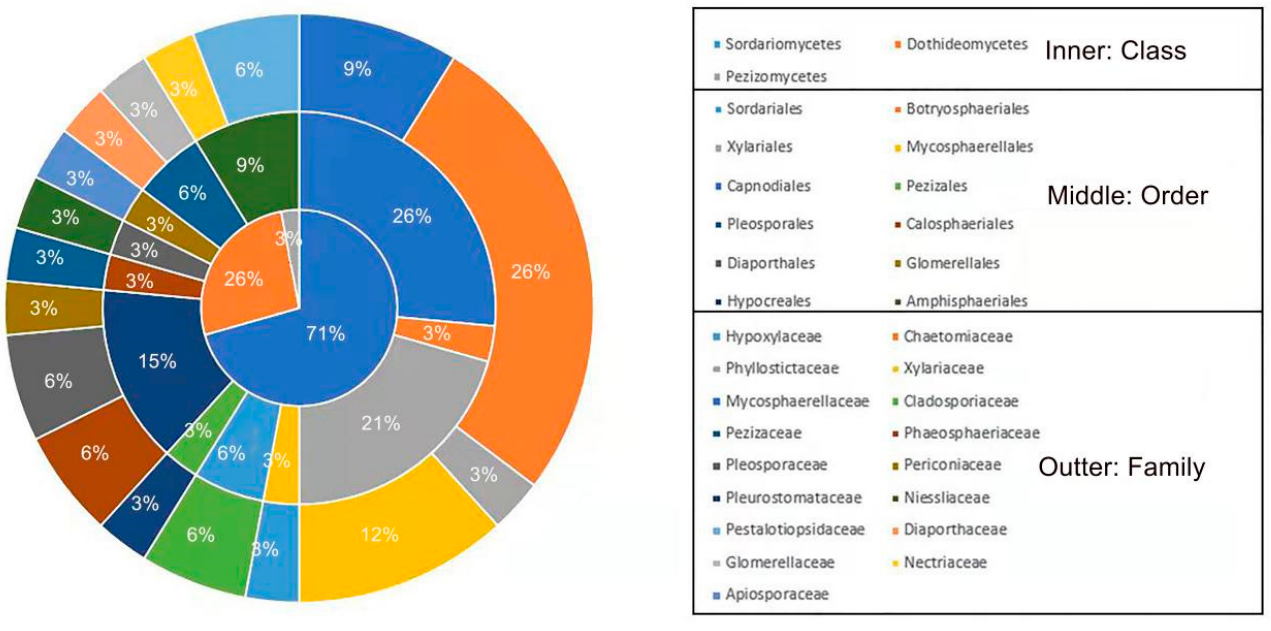
Figure 3. Classification of endophytic fungi (n = 34) associated with mango leaves.